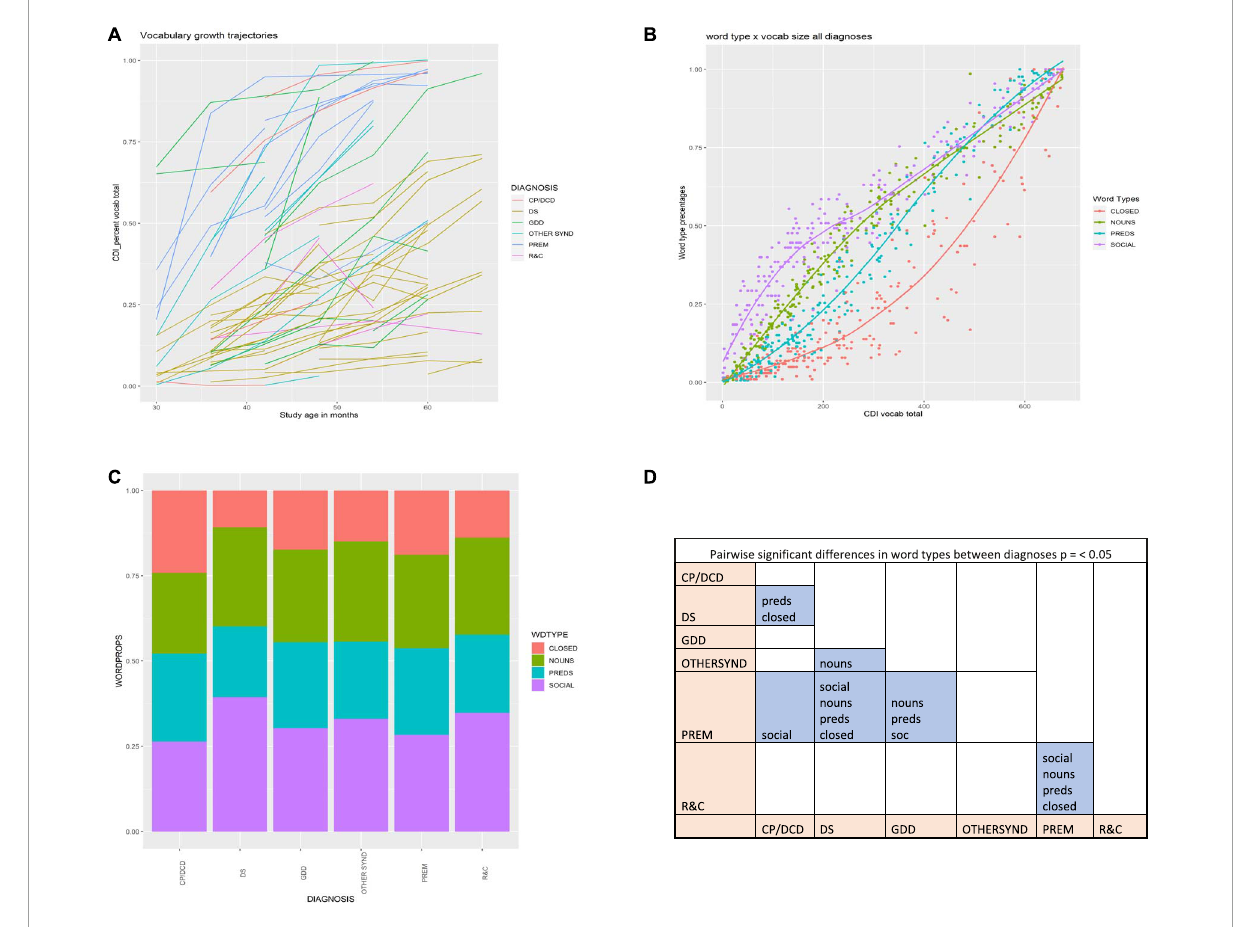
FIGURE3 (A) Change over time in vocabulary size color-coded for diagnosis. (B) Distribution of word types by vocabulary size. SOCIAL = purple; NOUNS = green; PREDS = teal; CLOSED = red. (C) Distribution of word types by diagnosis. (D) Significant pairwise differences at p ≤ 0.05. CP/DCD, cerebral palsy/developmental coordination disorder; DS, Down syndrome; GDD, global developmental delay; OTHER, other syndromes than DS; PREM, prematurely born; R&C, disorders of relating and